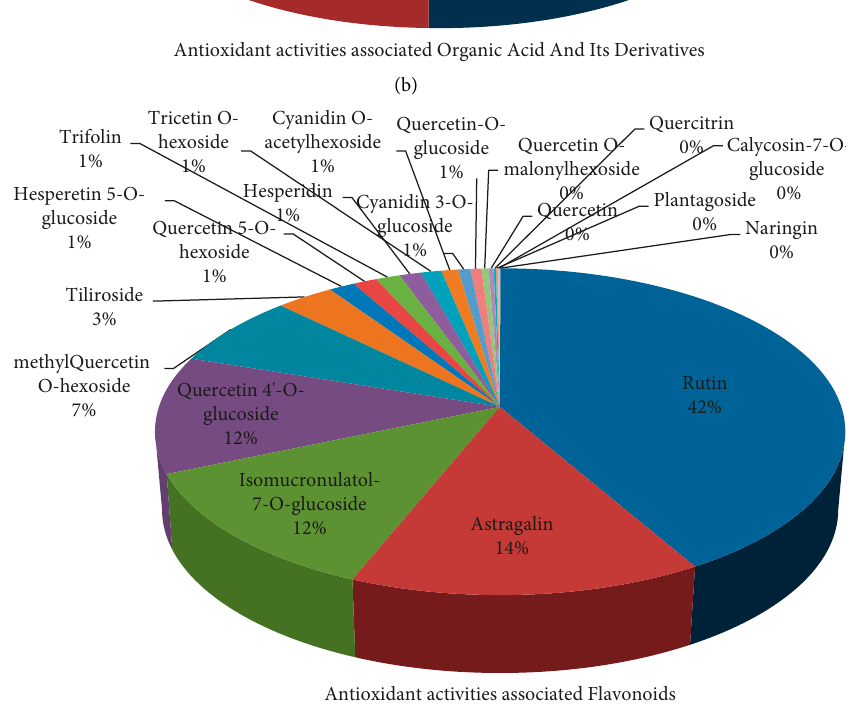
Figure 6: Detailed distribution of antioxidant activities associated metabolites in flower of D. nobile . (a) Antioxidant activities associated amino acid and its derivatives ( n � 13). (b) Antioxidant activities associated organic acid and its derivatives ( n � 11). (c) Antioxidant activities associated flavonoids ( n �